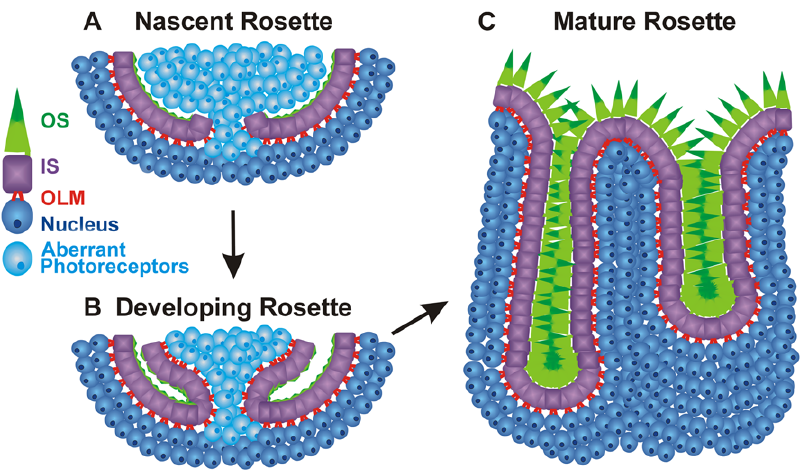
Figure 11. Model of rosette maturation. A. Nascent rosettes develop as abnormally migrating cell bodies (light blue) protrude through gaps in the OLM (red). These aberrant photoreceptors do not exhibit ISs or OLM junctions. B. As rosettes mature, the aberrant photoreceptors cells begin to develop ISs and OLM junctions. C. Mature rosette structure, in which the rosettes do not contain cell bodies.